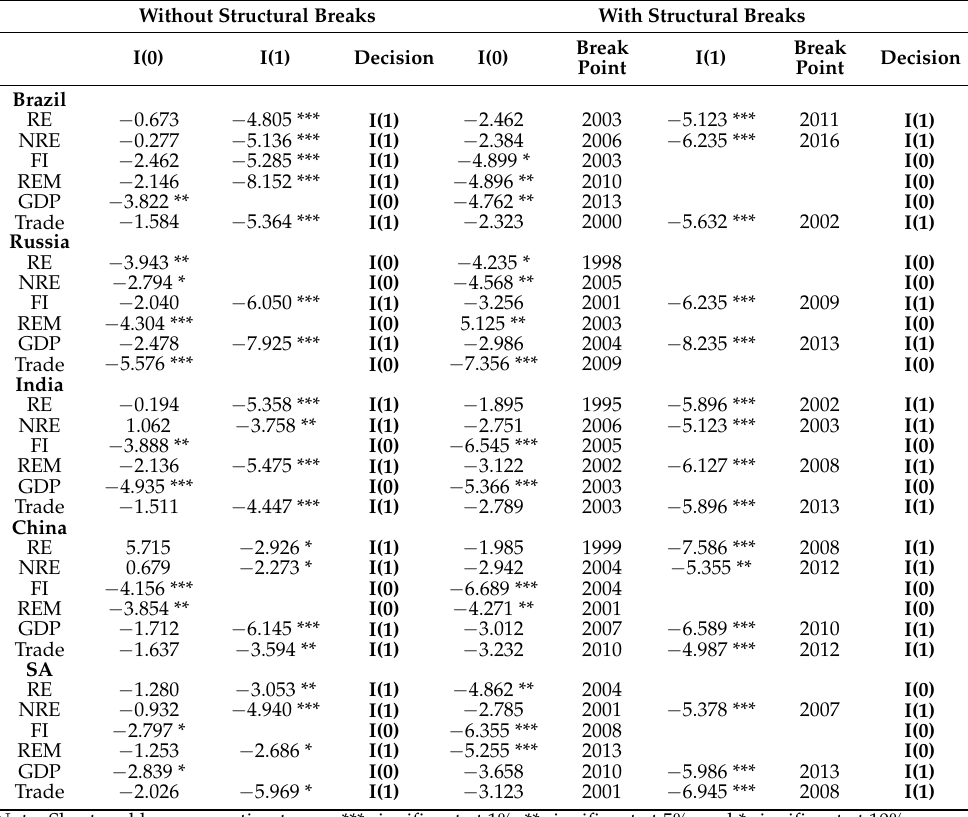
Table 2. Unite root tests with break and without break.